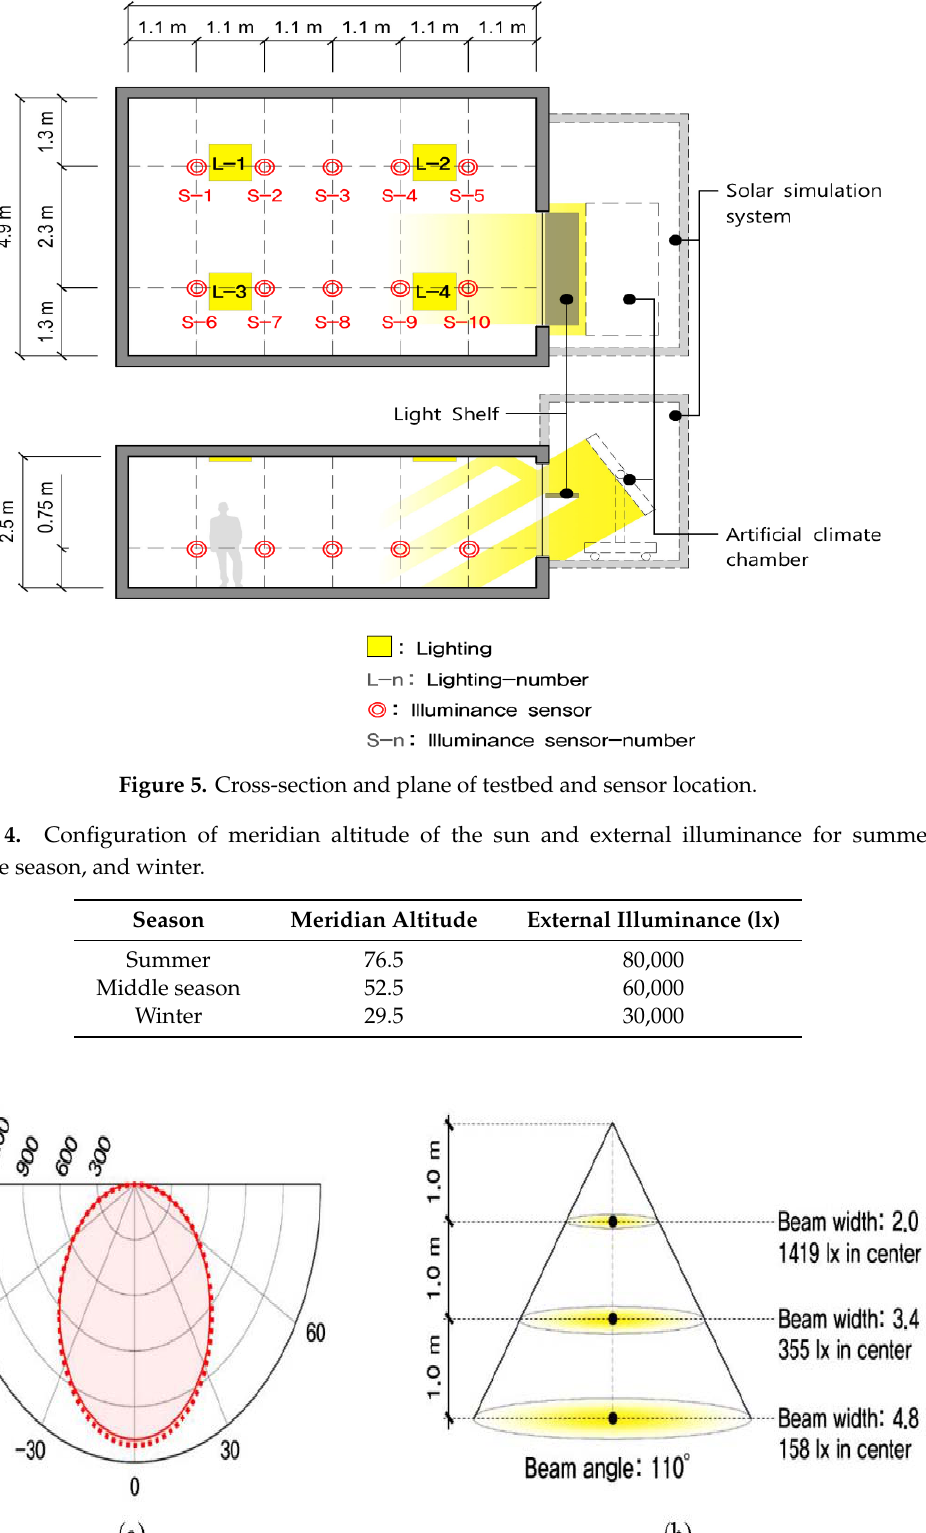
Figure 6. Light distribution curve and conical illuminance of lighting: ( a ) conical illuminance; ( b ) light distribution.